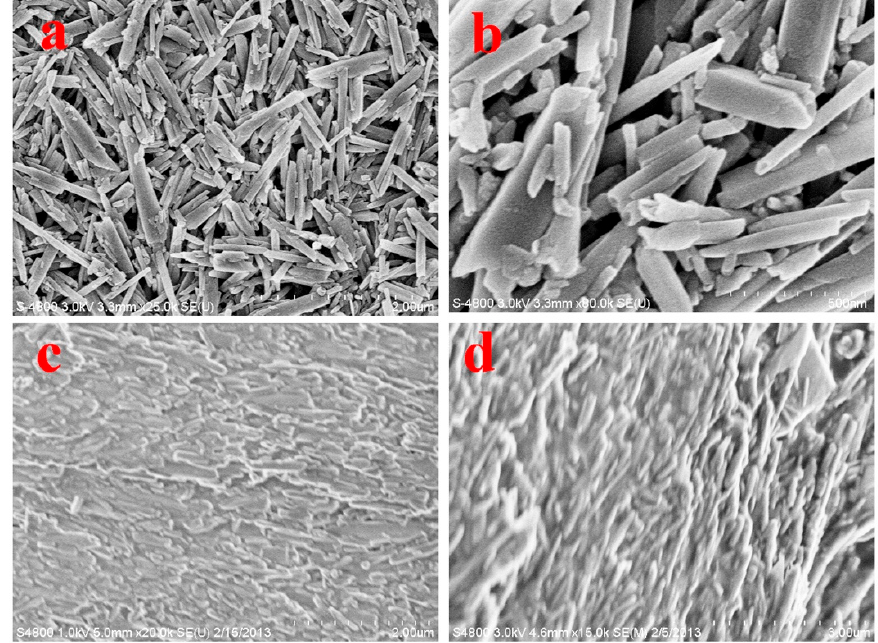
Figure 9. SEM images of halloysite ( a ); (50/50) wax/halloysite mixture ( b ); (45/45/10%) wax/halloysite/graphite mixture ( c ); and wax/halloysite/graphite/carbon nanotubes (45/45/5/5%) ( d )